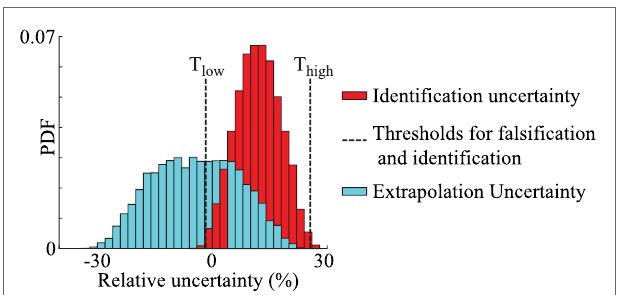
minimization, the equivalent stress range predicted is 14.6 MPa, which is biased from the value obtained using measurements.